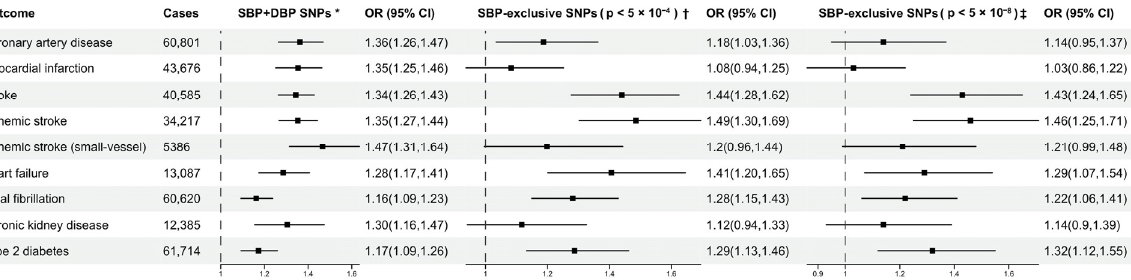
Figure 2. Mendelian randomization estimates (odds ratio with 95% CI per 10 mmHg increase in genetically predicted systolic blood pressure) from the inverse variance weighted method. SNP indicates single nucleotide polymorphism; OR, odd ratios; SBP, systolic blood pressure; DBP, diastolic blood pressure. * 242 SNPs associated with both SBP and DBP ( p < 5 × 10 − 4 ), identified in a BP GWAS meta-analysis study [17]. † 120 SNPs associated with SBP ( p < 5 × 10 − 4 ) but not associated with DBP. ‡ 63 SNPs associated with SBP ( p < 5 × 10 − 8 ) but not associated with DBP ( p > 5 × 10 − 4 ).